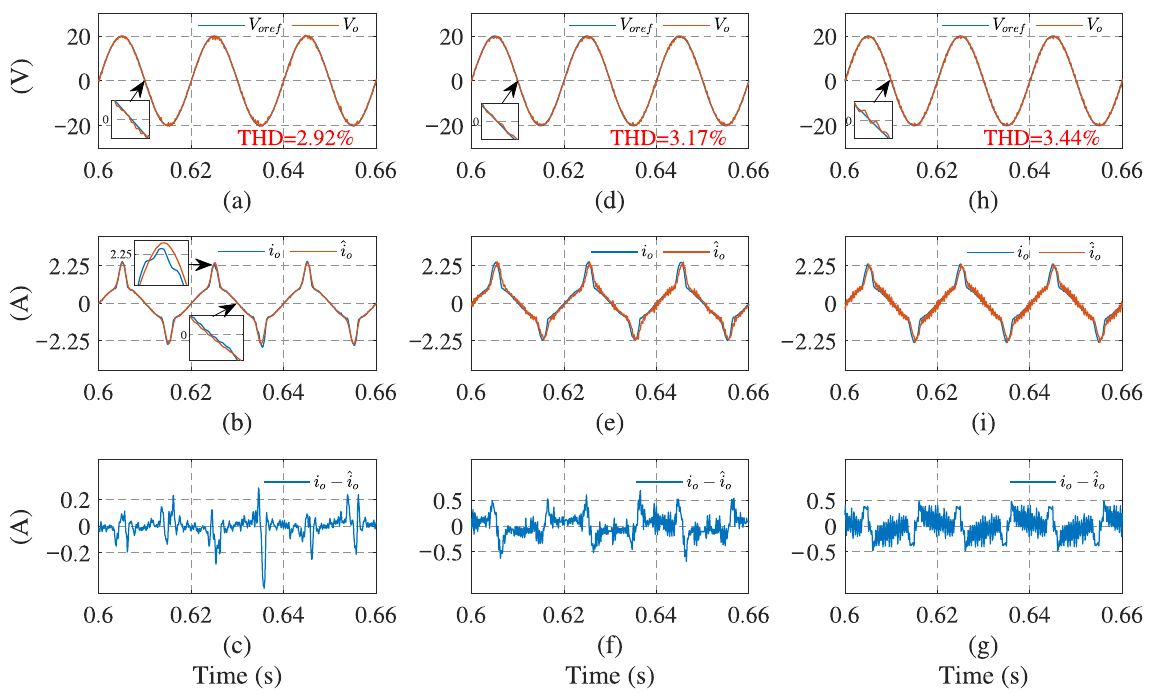
Figure 7. System simulation results using current estimation method under nonlinear load: ( a , d , h ) output voltage of observer, Kalman filter, and low-pass filter, respectively; ( b , e , i ) load currents of the three methods, respectively; ( c , f , g ) current estimation errors of the three methods,